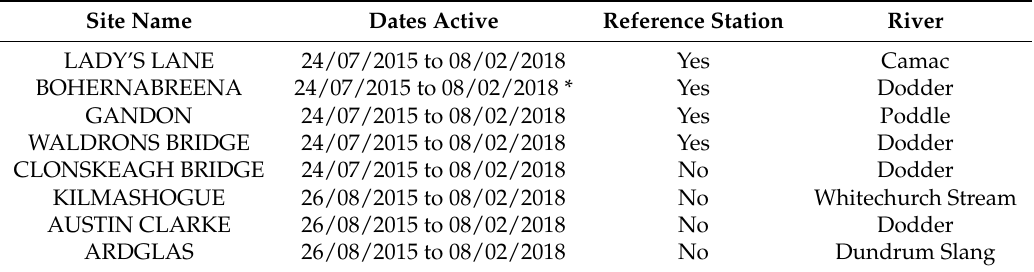
Table 1. Details of installed sensor units along the Dodder catchment. *Bohernabreena sensor readings are not valid after 06/03/2016 due to spiders in the